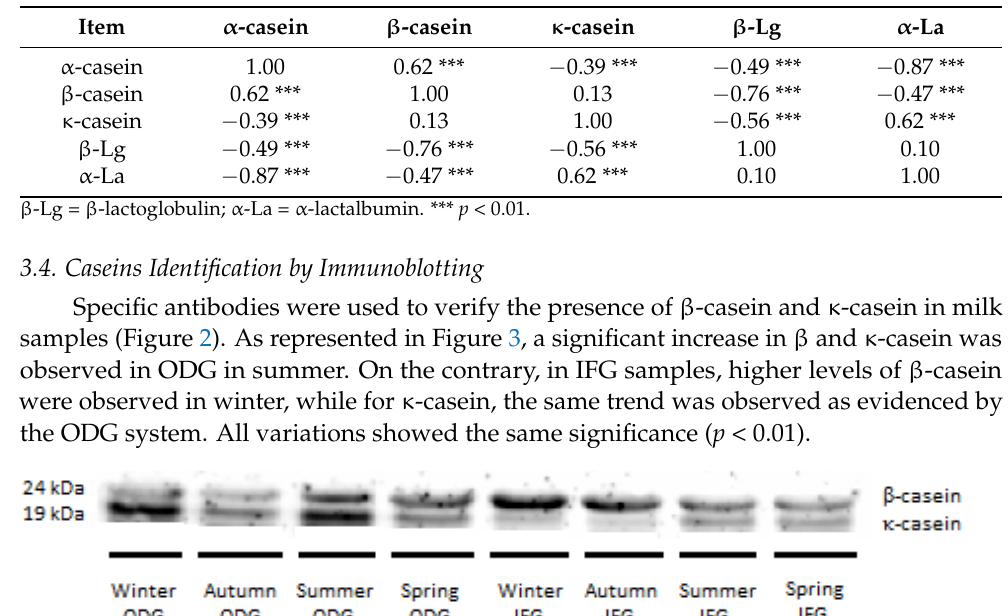
Figure 3. Immunoblotting of cow milk caseins during all seasons between ODG and IFG farming systems. Data are reported as area percentage ± S.D. of the total retinol concentration in each sample. p < 0.01. ODG: Outdoor grazing, IFG: intensive feeding. 3.5. Retinol Analysis The retinol (Vitamin A) concentrations are shown in Figure 4. Statistical significance was found between the ODG system and the IFG system ( p -value < 0.01). Concerning the ODG samples, the higher values were recorded during summer (23.88 ± 3.9 µg/mL) and the lower in winter (20.33 ± 4.69 µg/mL; p < 0.01). Regarding the IFG samples, the higher concentrations were instead reported during summer (11.2 ± 0.82 µg/mL) and the lower in winter (8.23 ± 2.69 µg/mL; p < 0.01). Figure 4. Retinol concentrations in milk during the winter and summer seasons between the two different farming systems. Data are reported as mean (µg/mL) ± S.D. of the total retinol concentra- tion in each sample. p < 0.01. ODG: Outdoor grazing, IFG: intensive feeding. 051015202530 R E T I N O L ( Μ G / M L )